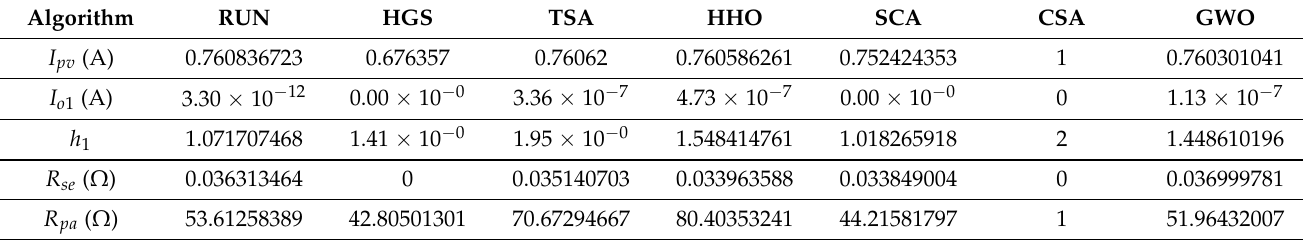
Table 5. The parameters estimated for TDSCM at the optimum